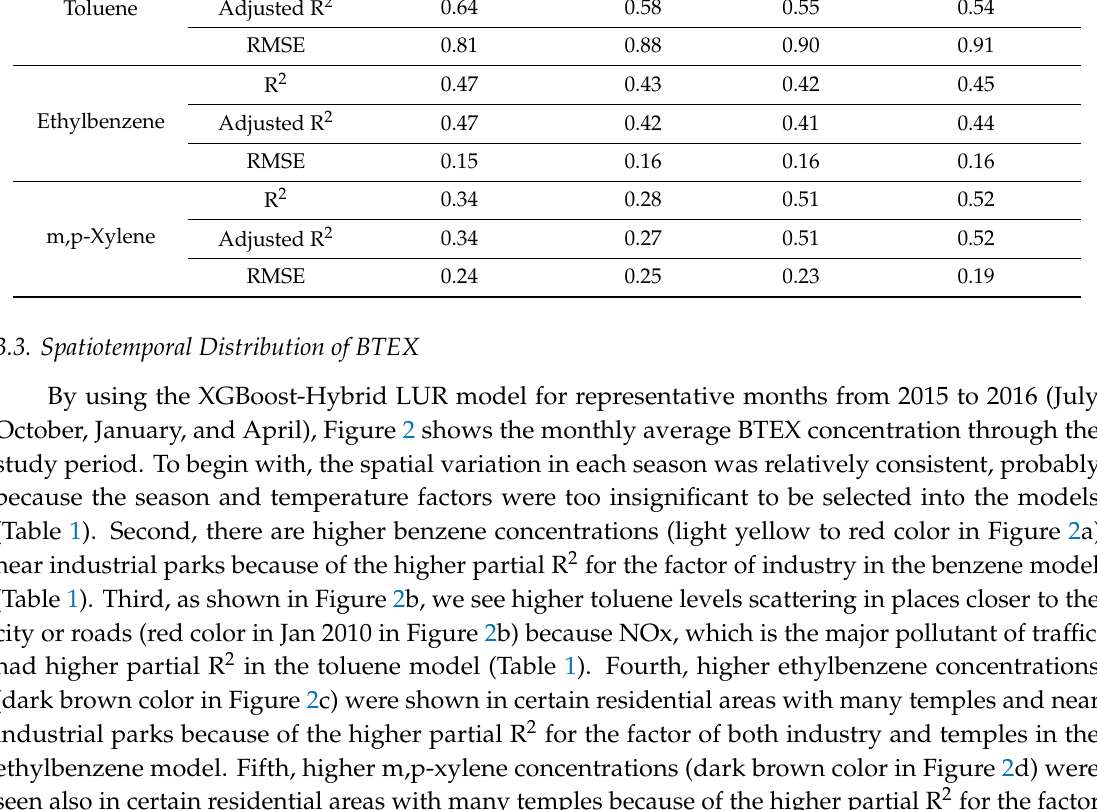
Figure 2. Monthly average concentration of BTEX: ( a ) benzene, ( b ) toluene, ( c ) ethylbenzene, and ( d ) m,p-xylene. 4. Discussion Most studies of exposure to ambient BTEX and health outcomes rely on daily monitoring of air pollution [40]. Few studies determine individual exposure levels using spatial analysis techniques [14,41,42]. These studies extrapolate actual measurements to individual exposures, so they do not reliably reflect the effect of air pollutants on health outcomes. This study proposes a method that is more economical than daily monitoring and more accurate than extrapolation to determine the effect of BTEX on health. Four spatiotemporal models are used to predict monthly average BTEX concentration from 2015 to 2018 at a resolution of 50 × 50 m. The models that combine Hybrid Kriging-LUR with machine learning (RF-Hybrid LUR and XGBoost-Hybrid LUR) have a greater predictive ability than the two regression models (Hybrid Kriging-LUR and GWR-Hybrid LUR). Specifically, the use of machine learning models in conjunction with land-use information increases the predictive power by 16% to 25% over that of the regression models. This increase is attributable to the fact that both the RF and XGBoost methods identify potential nonlinear associations between candidate predictors and ambient BTEX. To the authors’ best knowledge, this is the first study to compare machine learning and standard linear regression models to predict spatial differences in ambient BTEX. It is shown that both machine learning models (RF and XGBoost method) have a greater predictive power than standard approaches. XGBoost-Hybrid LUR is demonstrated to be the best model in this study and better explains the spatial variation in ambient BTEX in south Kaohsiung. The model also performs acceptably when verified using an external dataset. To address the problem of overfitting, 80% of data was used to train the XGBoost-Hybrid LUR model and 20% to test it. The adjusted R 2 values for training and testing are similar to those for the original model so there is no overfitting problem. The variables were selected using the Hybrid Kriging-LUR model and then used for the other three models developed by this study. Most of the significant variables are similar for the prediction of BTEX using the Hybrid Kriging-LUR model, but the individual contribution of each variable to the models is different. For example, while industrial area is a significant variable in predicting benzene, toluene, ethylbenzene, and m,p-xylenes, the significance of this variable (24%, 3%, 16%, and 8%, respectively) is different for each model (Table 1). This difference is probably caused by different